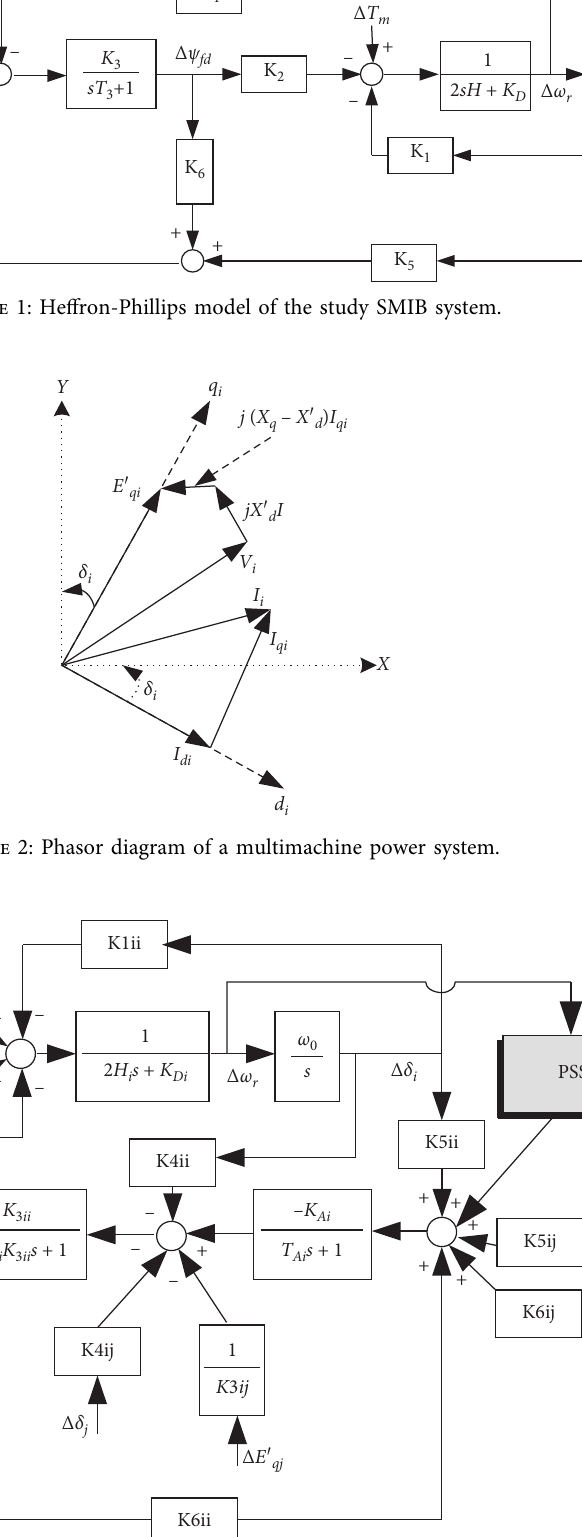
Figure 3: A multimachine power system Hefron-Phillips